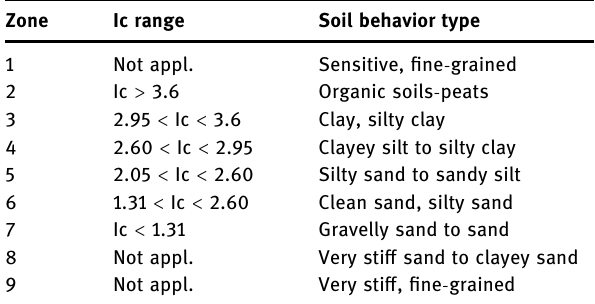
Figure 1: Location of the CPTs [ 4 ] .